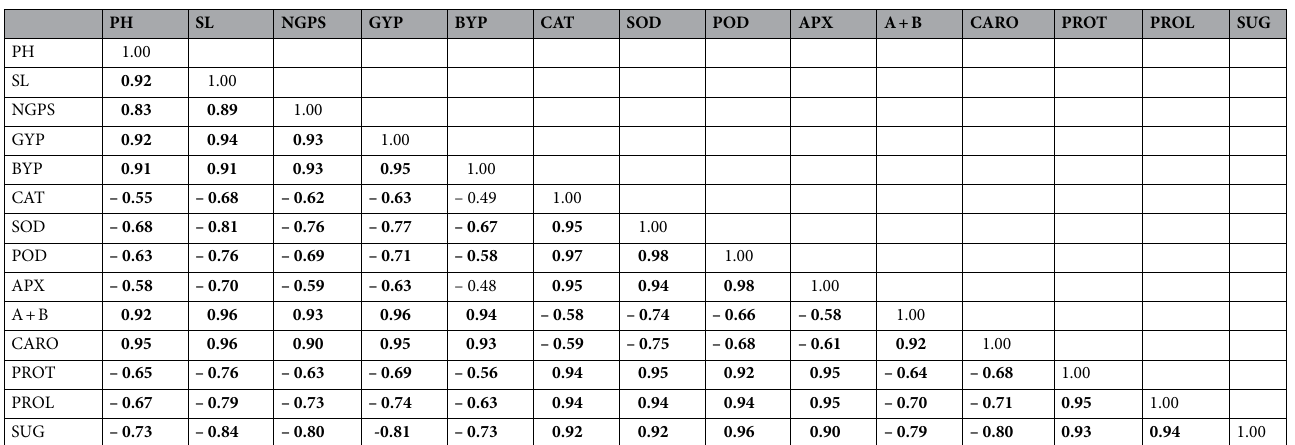
Table 1. Correlation analyses among different yield related traits, physiological traits, antioxidant enzymatic activities and osmo-protectant. For bold values p < 0.01; for non-bold values p < 0.05; n =